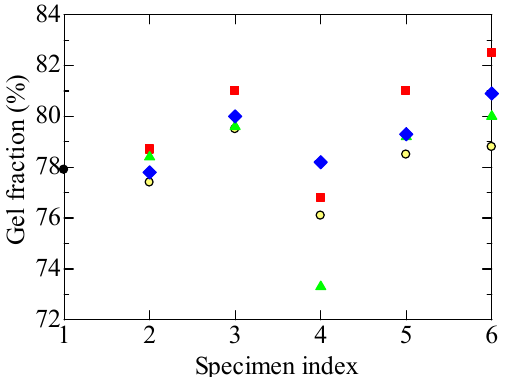
Figure 9. Changes in gel fraction at each stage for various tubular specimens. Refer to Tables 1 and 2 and Figure 4 for the meanings of the numerals on the abscissa and sample symbols. Several data may overlap each other.